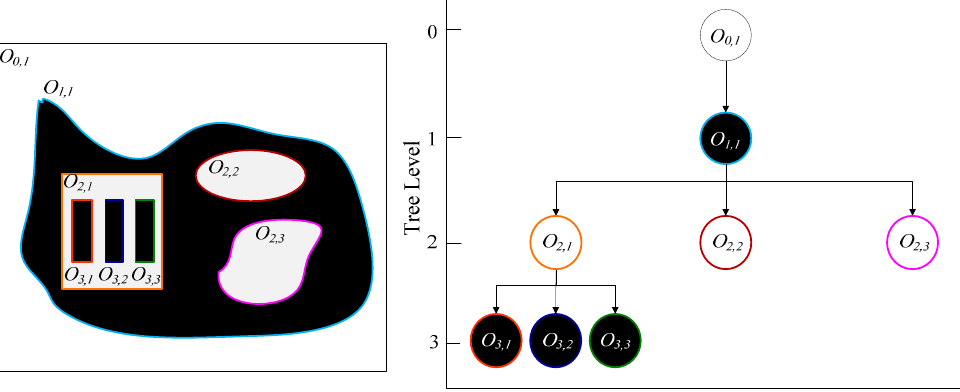
Figure 3. An example that illustrates the building of a tree structure.